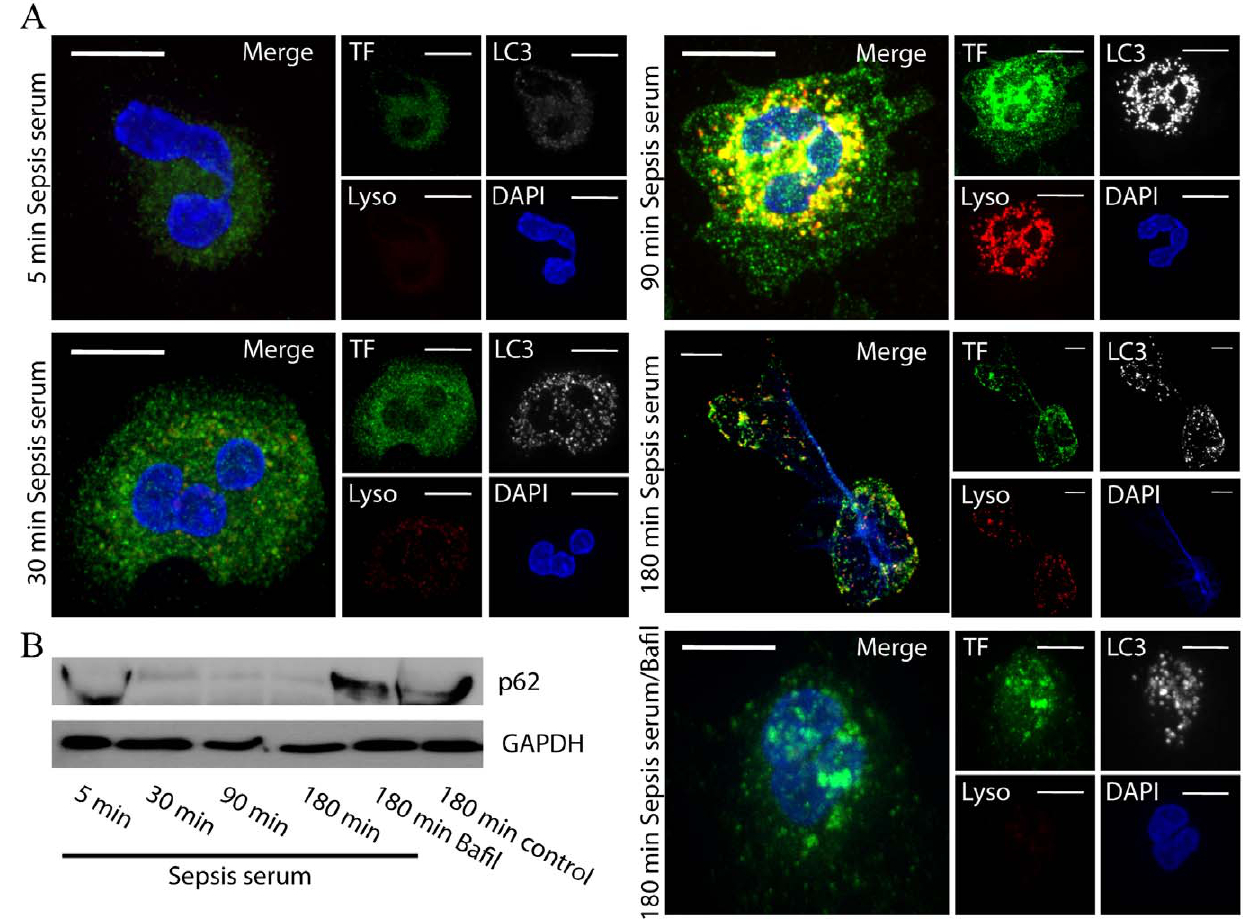
Figure 8. Formation of autophagolysosomes in control neutrophils treated with sepsis serum and degradation of p62/SQSTM1. A. Control neutrophils were treated at different time points with sepsis serum and the localization of TF in autophagolysosomes was assessed. Autophagolysosomes were visualized as LC3B and LysoTracker double positive structures and were assessed by confocal microscopy (z stack analysis, 0.3 m m per plane). (DNA labeled with DAPI; blue, anti-LC3B mAb; white, anti-TF; green, LysoTracker; red) (original magnification 1000 6 ). Scale bar represents 5 m M. B. p62/SQSTM1 protein levels in control neutrophils treated with sepsis serum at different time points. Treatment with bafilomycin A1 inhibited p62/SQSTM1 degradation. One out of three independent experiments is shown in A–B.